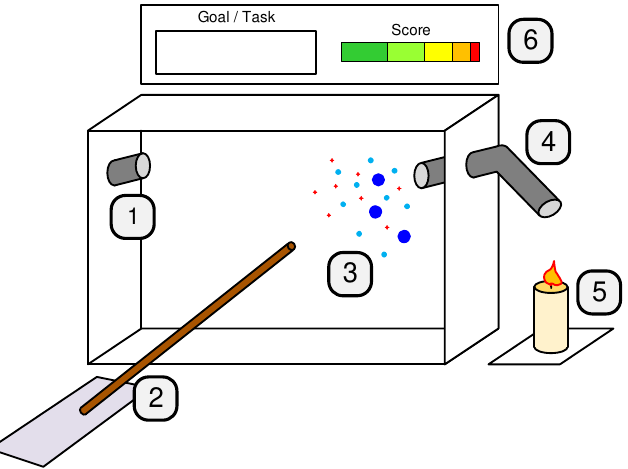
Figure 2. Gaming experience illustration. 1—air extraction tube (virtual); 2—“wand” for interaction with the experience (mixed); 3—representation of different air pollution compounds (virtual); 4—air inlet tube (real); 5—area for placing sources of pollution (real); 6—goals/score chart UI